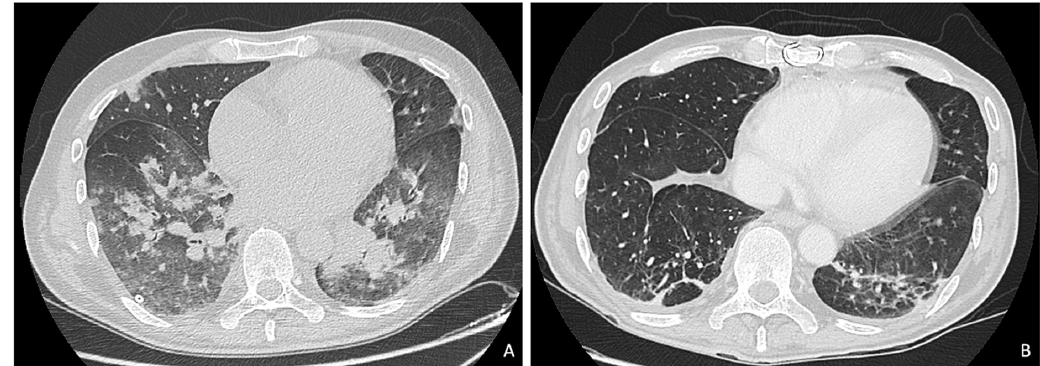
Figure 2. Pre- and post-operative thoracic computed tomography (CT) scan. CT imaging showing COVID-19 pneumonia ( A ) and its resolution ( B ) after three months.